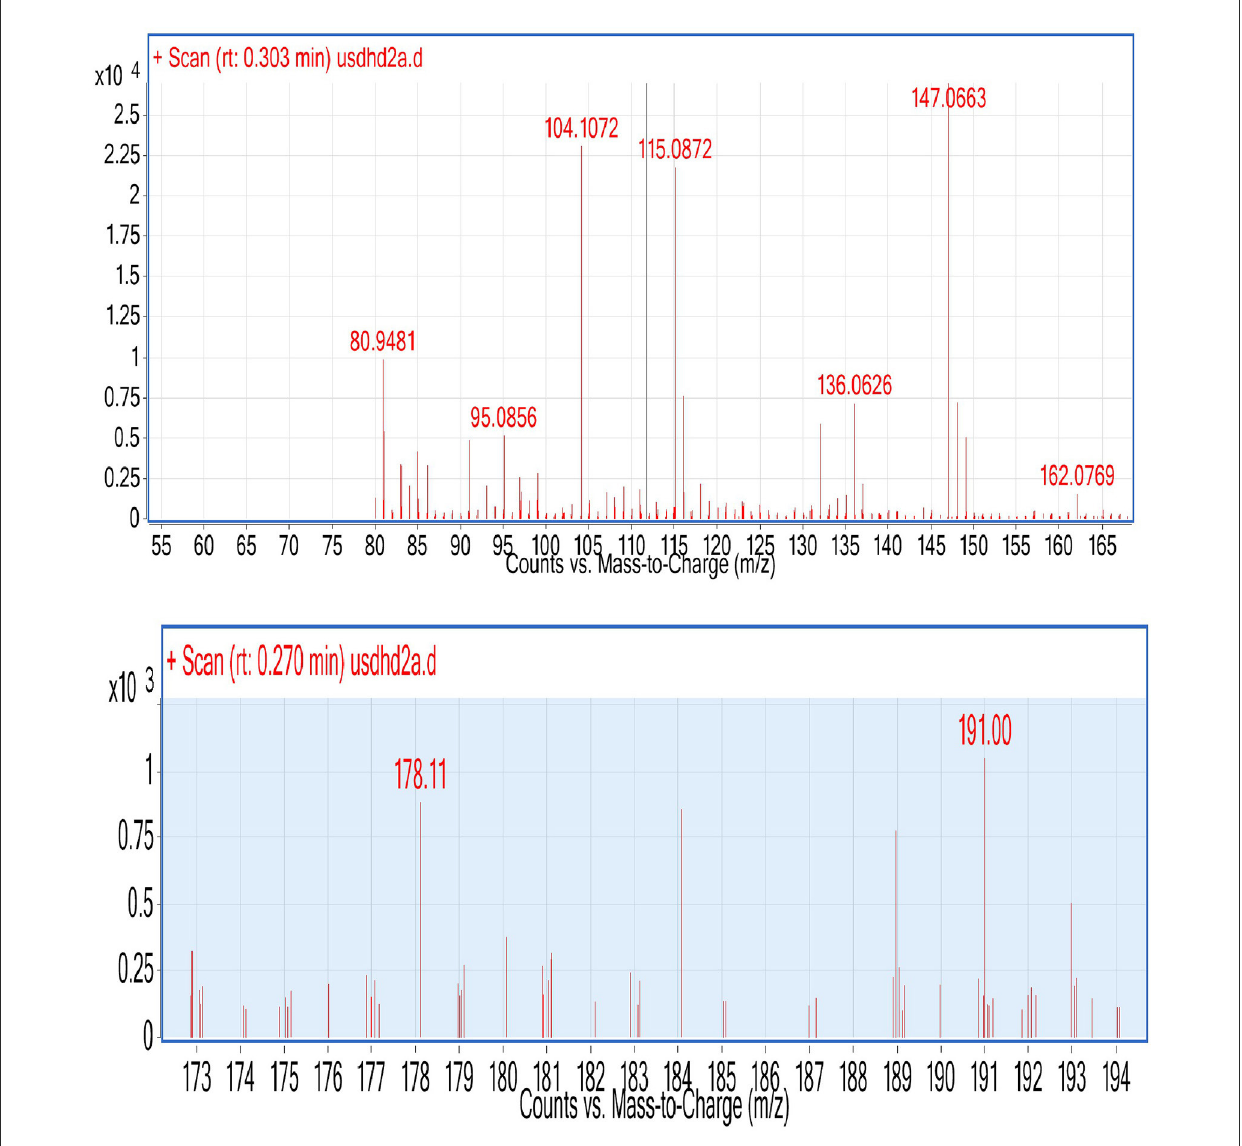
FIGURE11 ESI (Electrospray ionization)-MS results of L3, P2, and CNS for the detection of organic